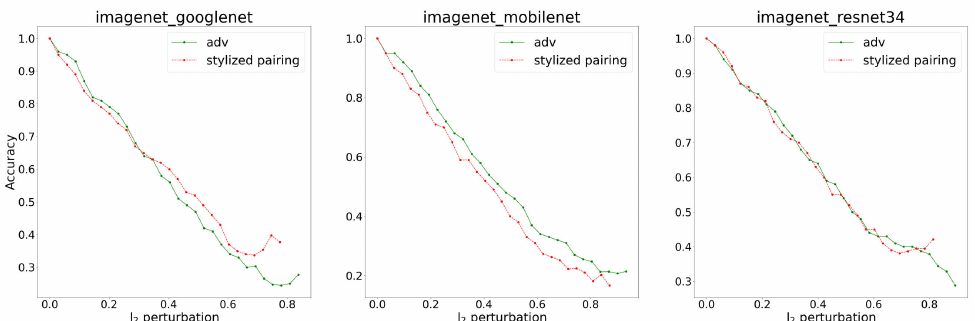
Figure 4. The performance comparisons between models with stylized pairing training and those with adversarial training on ImageNet. The red lines refer to stylized pairing training and the green lines refer to adversarial